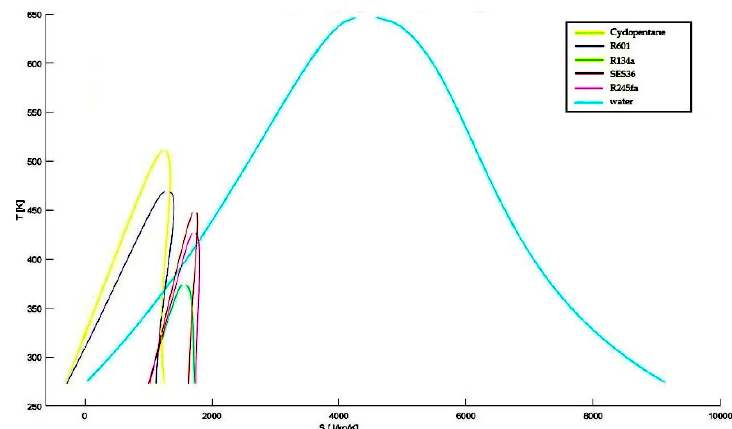
Figure 2. Temperature–entropy diagram for the fluids considered in this study fluids, in the same scale as the usual water Mollier diagram.